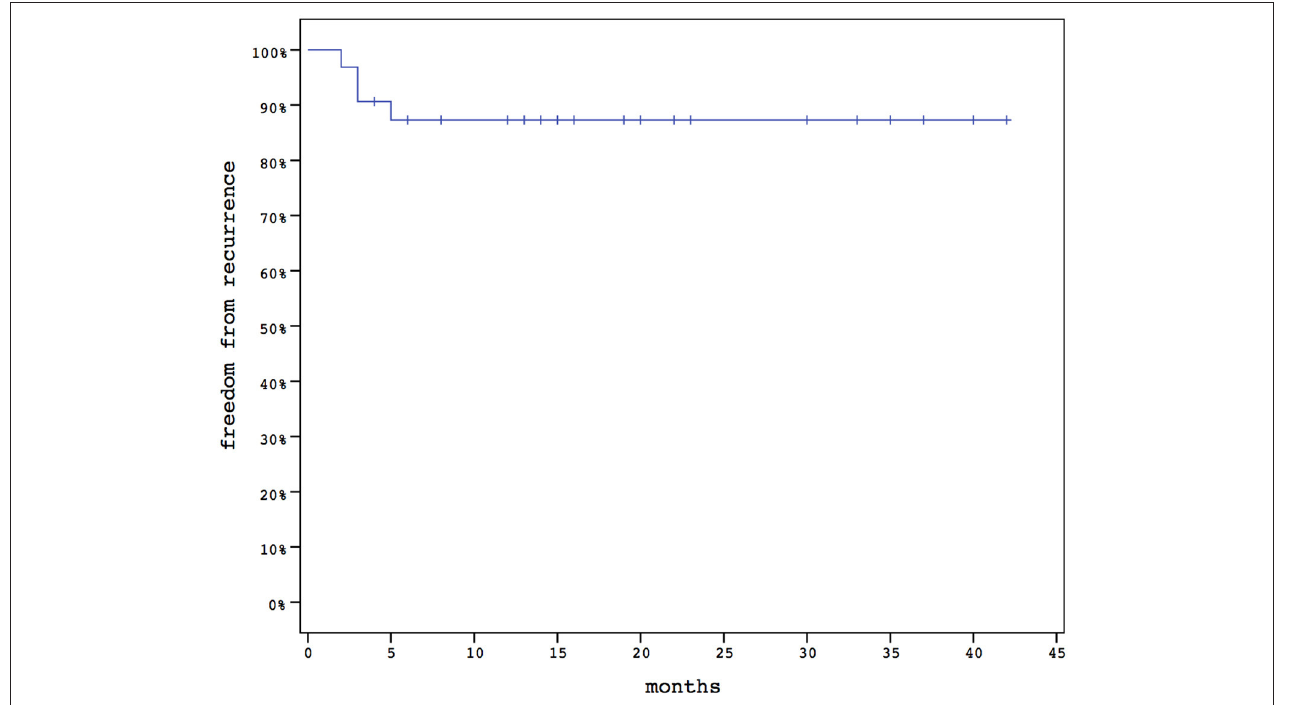
FIGURE 1 | Recurrences during follow-up.